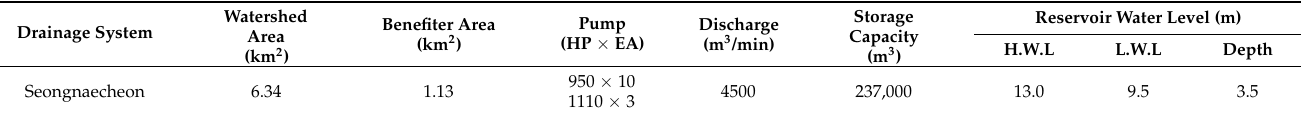
Figure 13. GIS map of the Gildong watershed. Table 4. Specifications of the Seongnae rainwater pump station.